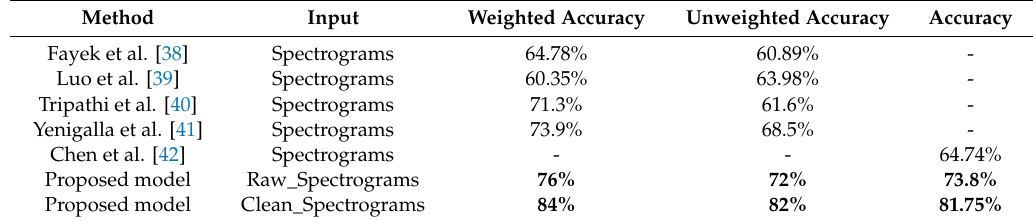
Table 8. Comparison of the proposed method with base line method using IEMOCAP